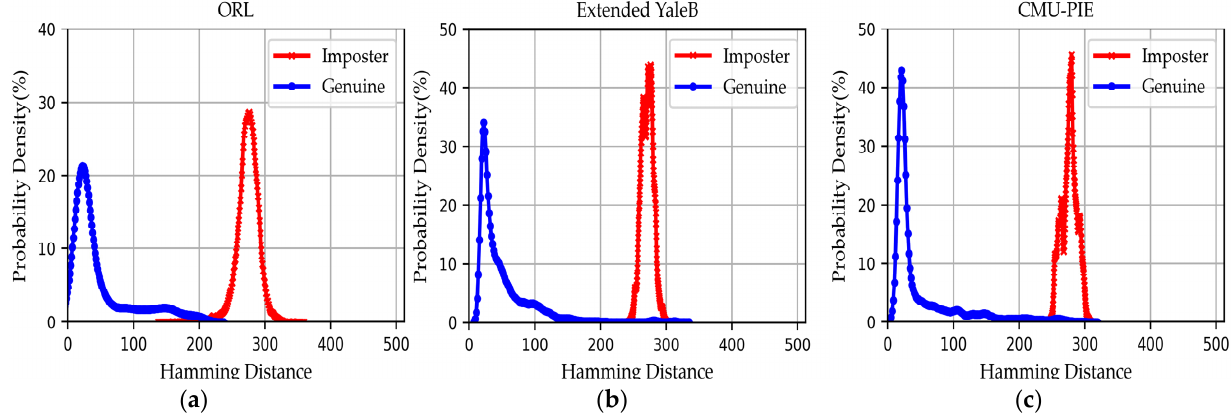
Figure 8. The distributions of Hamming Distance between the imposter and the genuine, applied on ( a ) ORL dataset at 𝑙 = 512 ; ( b ) Extended YaleB at 𝑙 = 512 ; ( c ) CMU-PIE at 𝑙 = 512 .